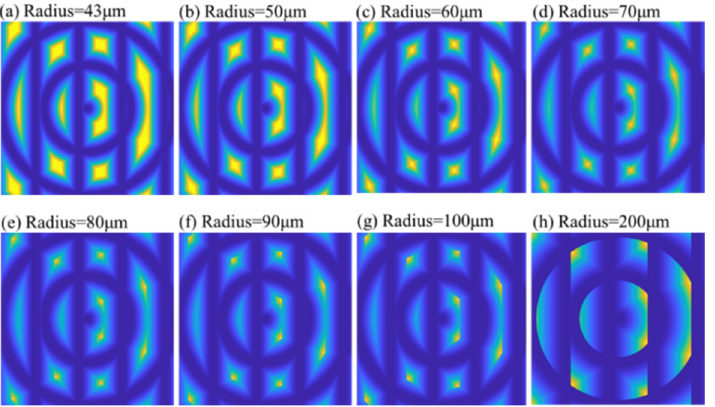
Figure 14. Comparison of simulated surface topography of a polar microstructure with different tool nose radii. Other important machining parameters: groove spacing: 50 μ m, depth of cut: 5 μ m.